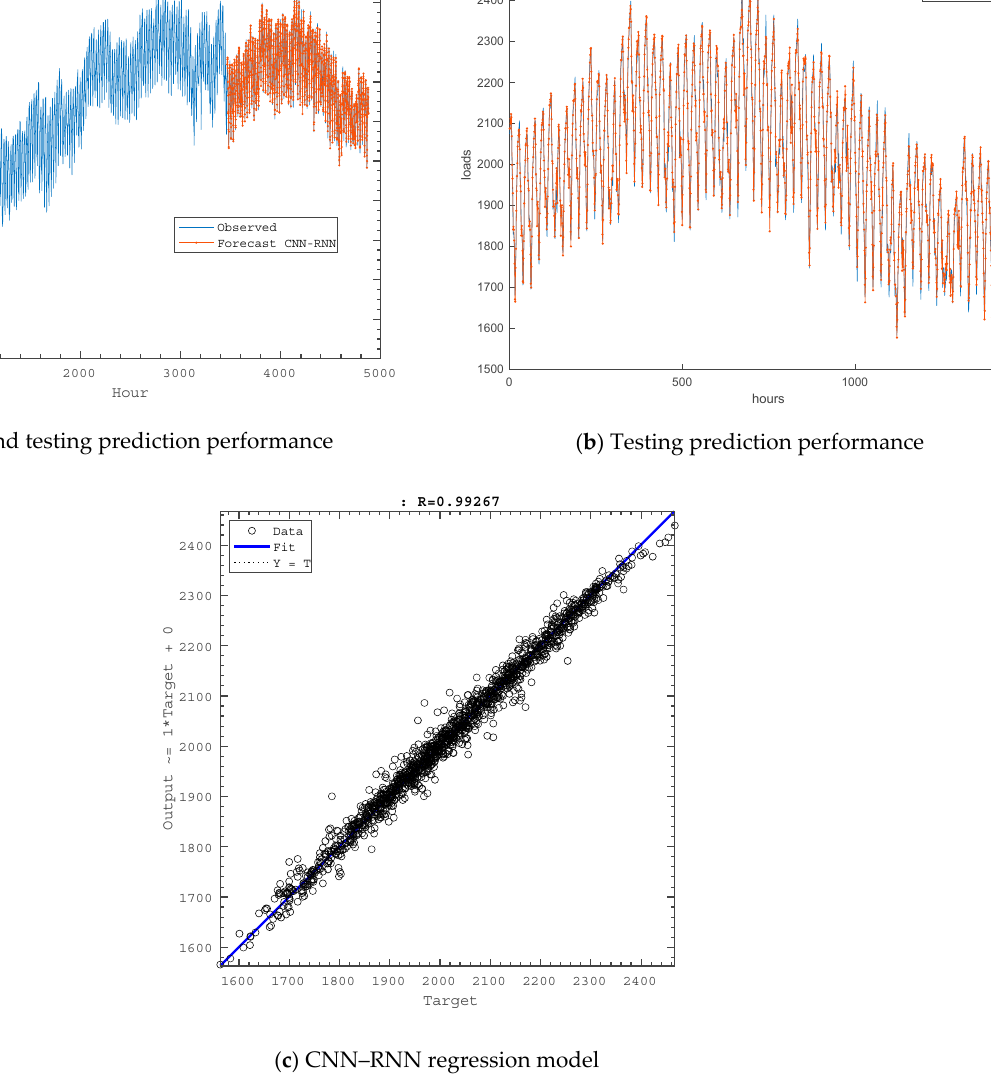
Figure 14. CNN–RNN model prediction performance for the Madinah load: ( a ) training and testing, ( b ) testing, and ( c ) regression plot.